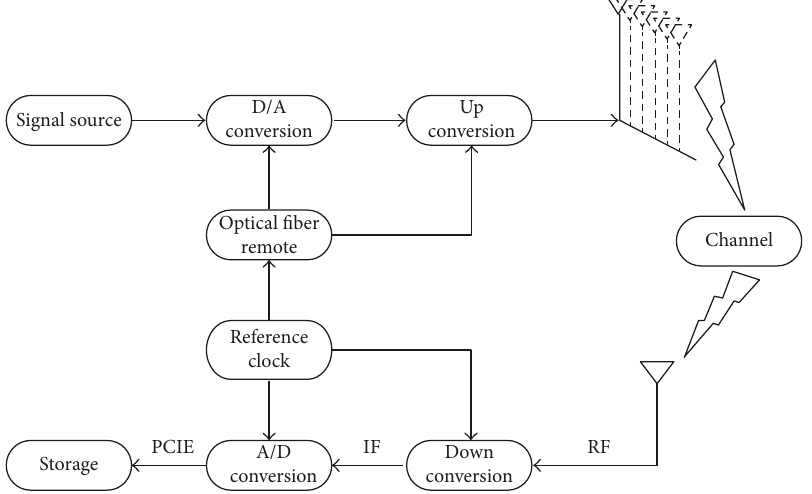
Figure 1: Overview of the measurement